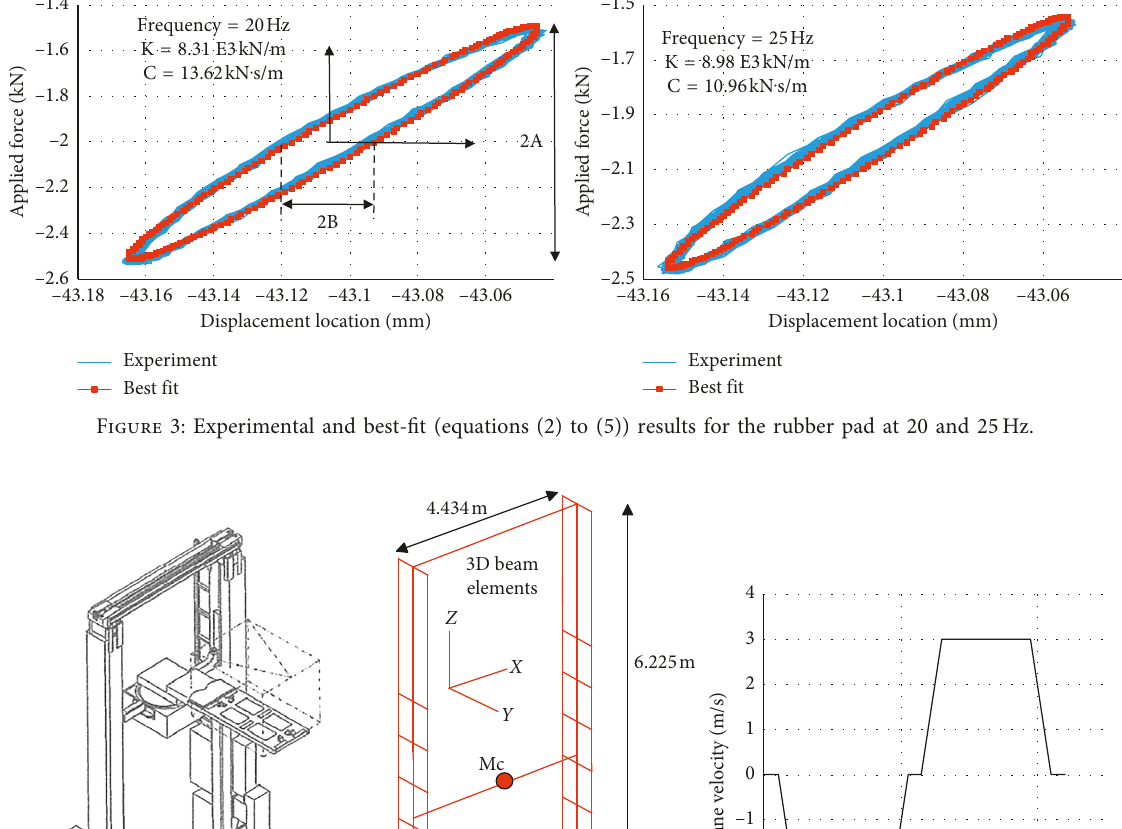
2t, Ms 0.9 t Kr 0.4E5kN/m, Ks (cid:30) (cid:30) (cid:30)